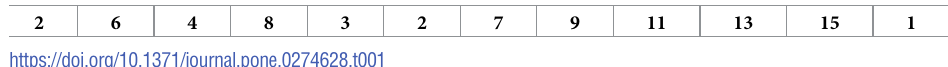
Table 2. Sliding window with 3 sub-array length.